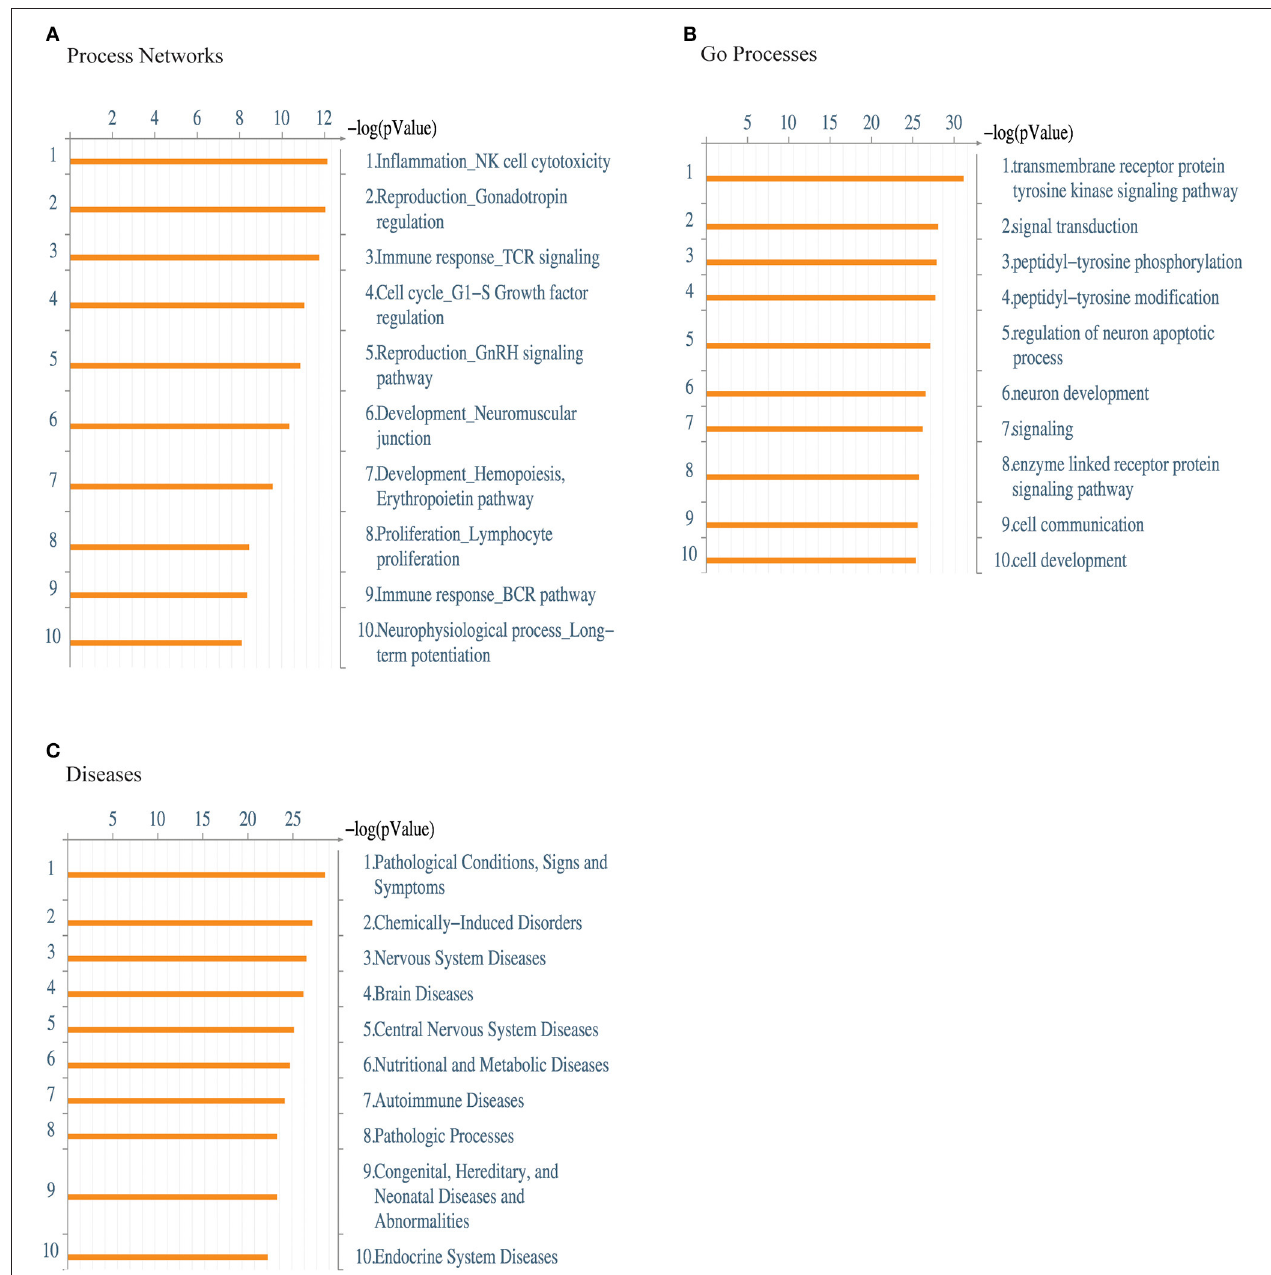
FIGURE 4 | Enrichment analysis of the kinome array data. Functional ontology enrichment analysis using the MetaCore TM database reveals (A) the distinct biological networks, (B) the different biological processes, and (C) various diseases related to kinases identified in Figure 3 . The probability of a random intersection between the set of kinases with ontology entities was estimated with the “ p ” value of the hypergeometric intersection. A lower “ p ” value means higher relevance of the entity to the dataset, which appears in higher rating for the entity.